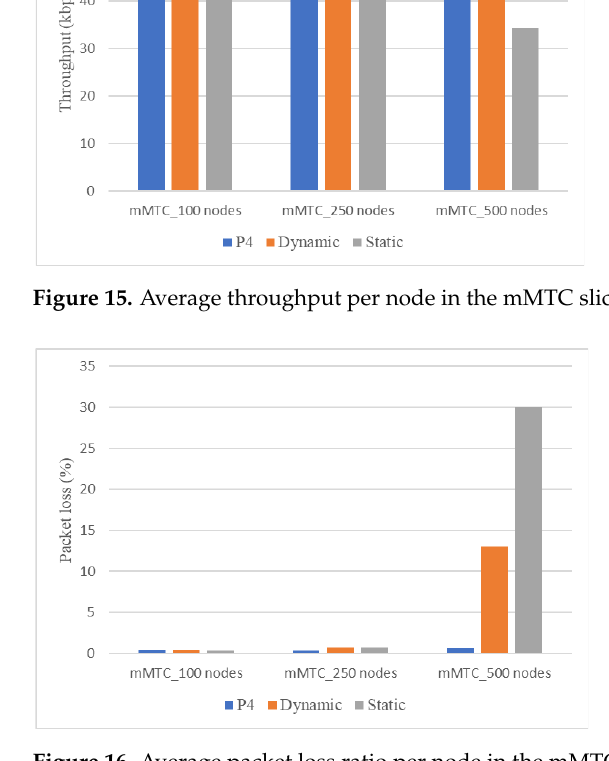
Figure 16. Average packet loss ratio per node in the mMTC slice.